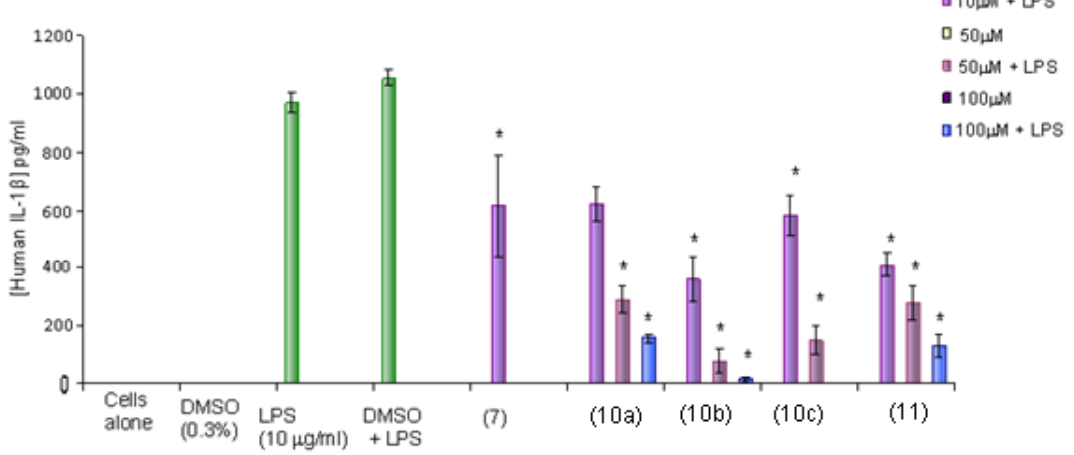
Figure 8. The effects of curcumin ( 7 ) and thiophene curcuminoids 10a – c , 11 on the production of IL-1 in LPS-induced THP-1 cells using ELISA assay. Results are presented as mean ± SD. * p < 0.05 compared with DMSO + LPS control, * p > 0.05 compared with curcumin control ( 7